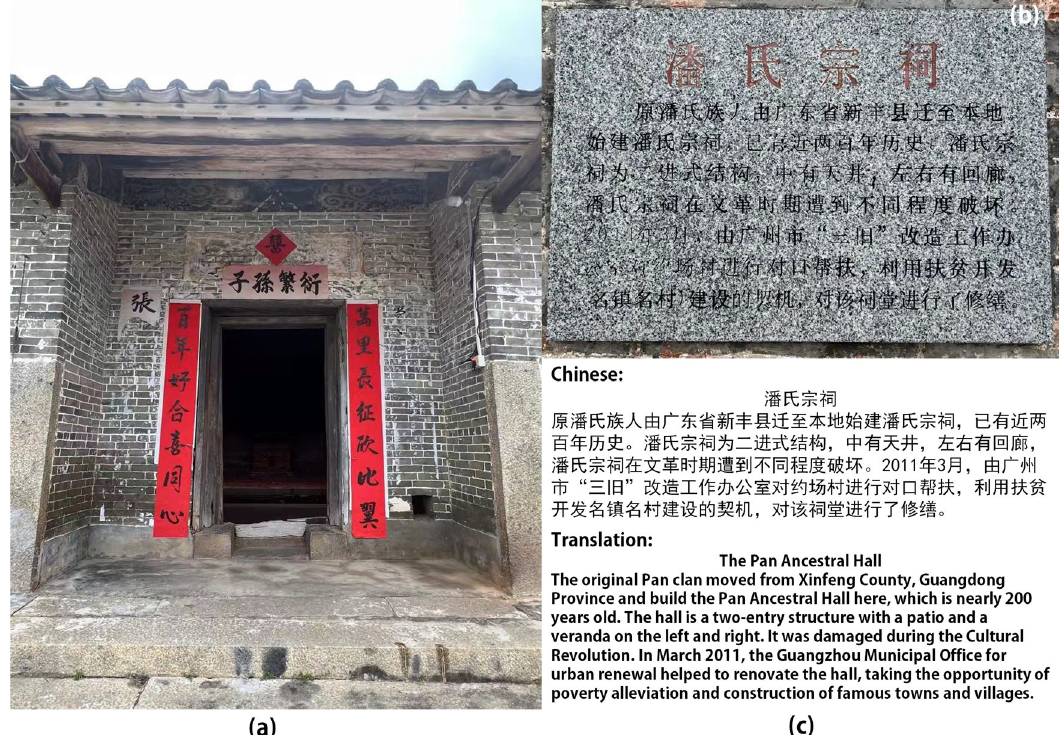
Fig. 8 The Pan Ancestral Hall in Yuechang Village of Zengcheng County, Guangzhou. a The photo of the main entrance of the ancestral hall. b The stele in the ancestral hall recording the migration record of the village. c The text on the stele and its